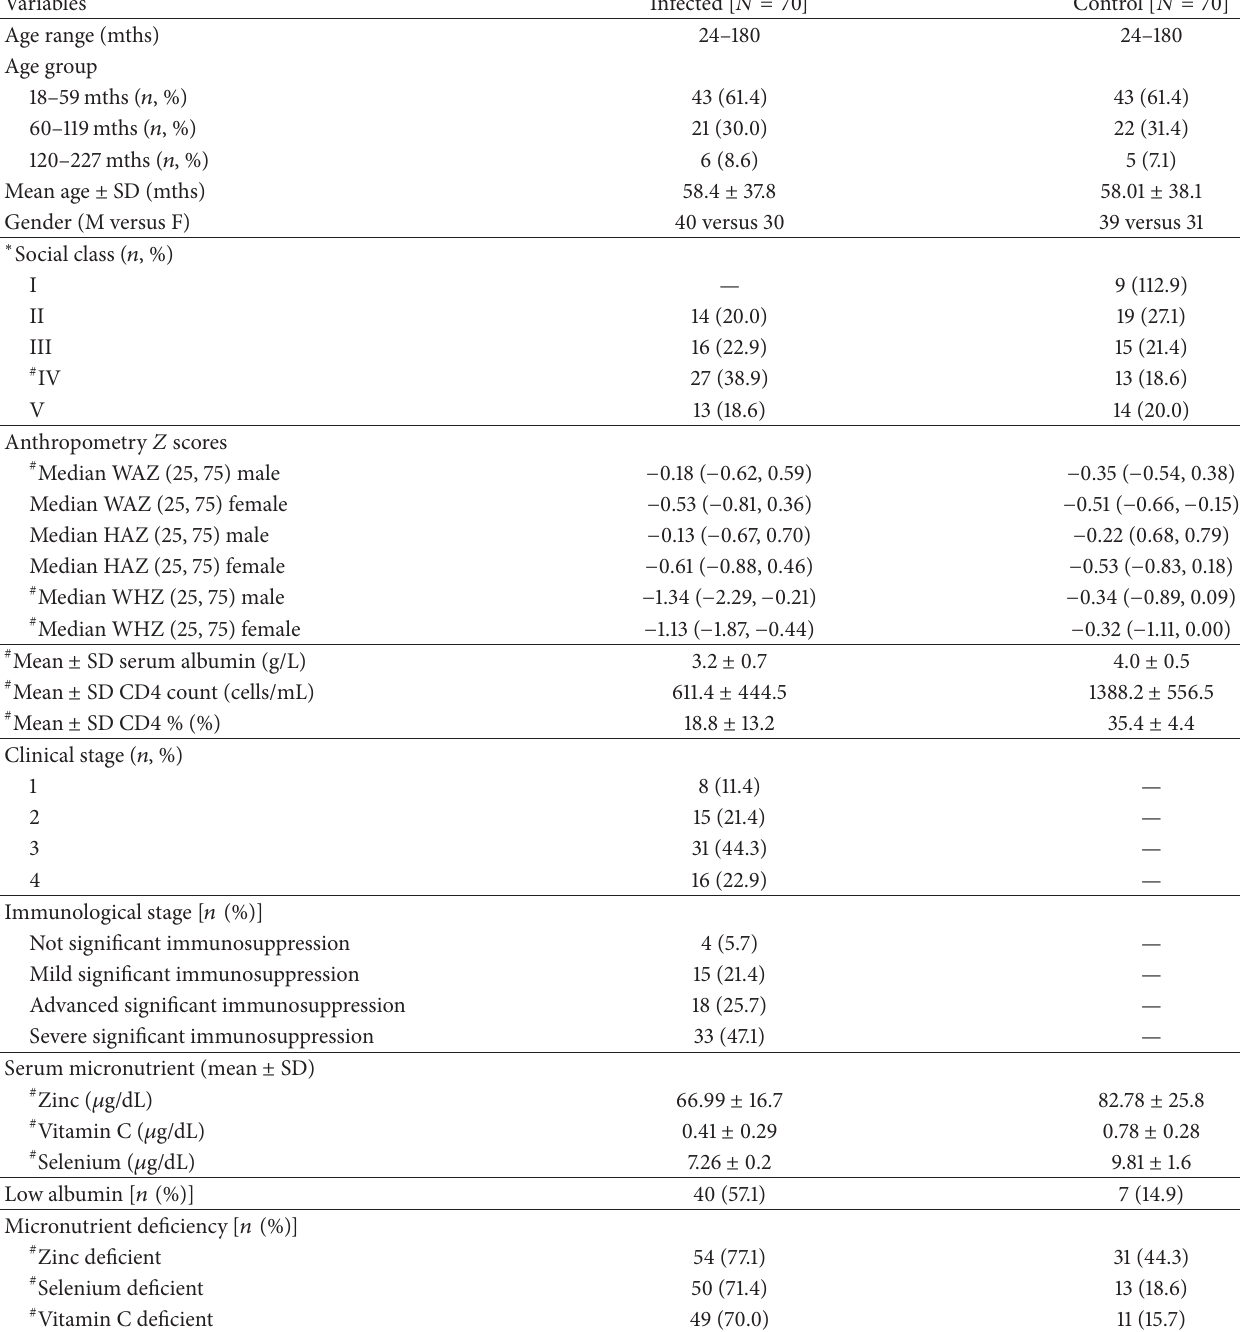
Table 1: Demographic, clinical, and micronutrient data of HIV infected subjects and the HIV negative